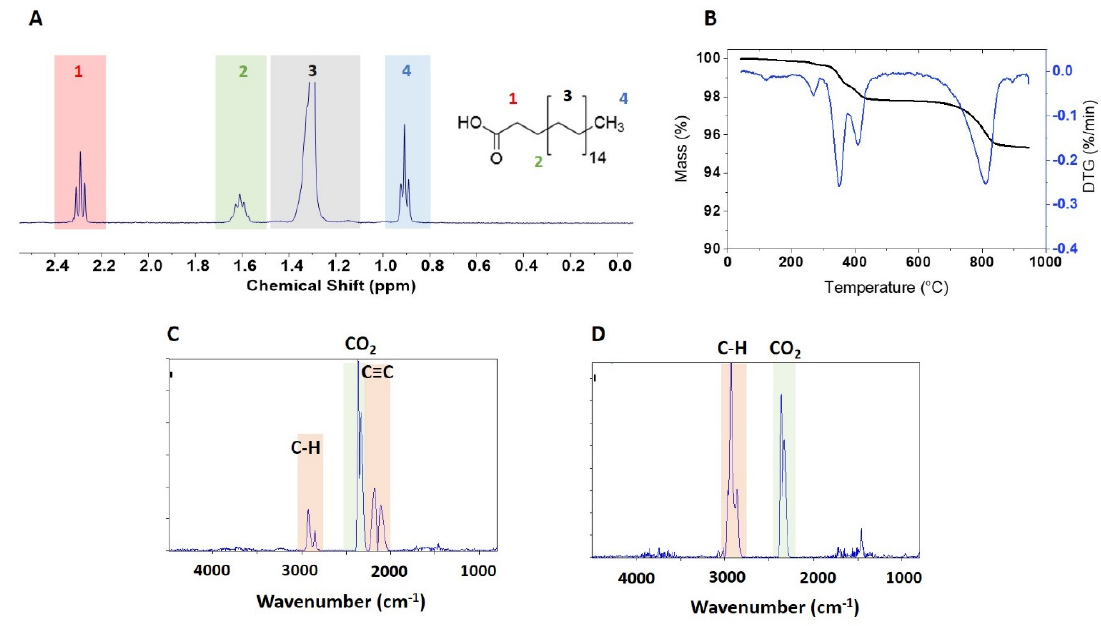
Figure 5. Characterization of stearic acid functionalized ZnO sample NRC-01-C18: ( A ) 1 H NMR spectra of solubilized stearic acid in 16% TFA-d in methanol-d 4 ; ( B ) representative thermogram and ( C , D ) FT-IR spectra of evolved gases measured at 407 ◦ C ( C ), and 814 ◦ C ( D ).